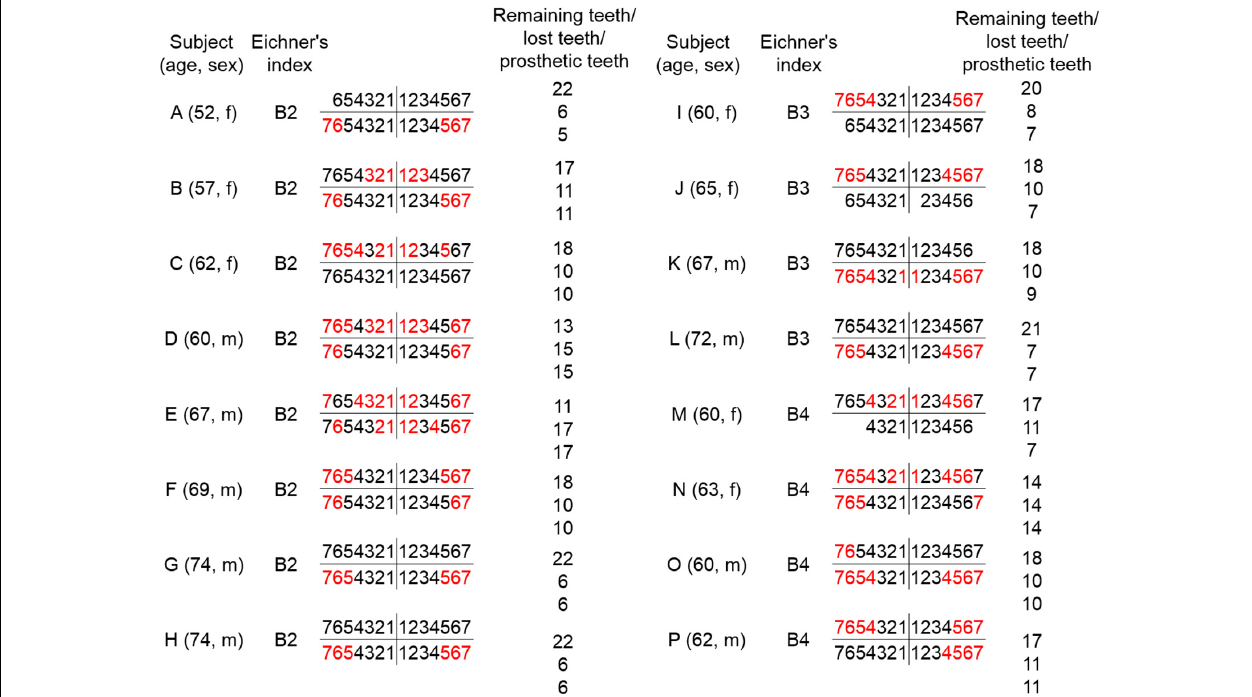
FIGURE 1 | Age, gender, and dental state in partially edentulous patients. Age, gender, and dental state for each of the 16 partially edentulous patients (A–P) are shown. Subjects A–H , I–L , and M–P were classified as B2, B3, and B4, respectively, according to Eichner’s intermaxillary tooth contact classification. The remaining teeth are indicated in black and prosthetic teeth in